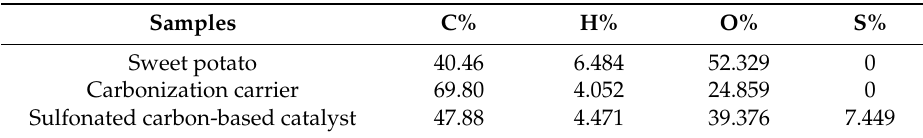
Table 5. Elemental analysis of sweet potato, carbonized carrier and sulfonated carbon-based solid